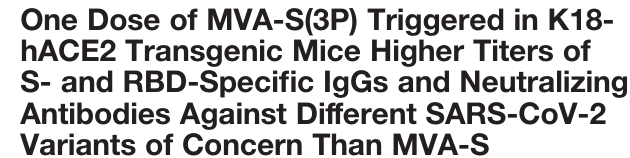
12b, CCL11, IP-10, and IFN- g mRNA levels ( Figure 5C ).